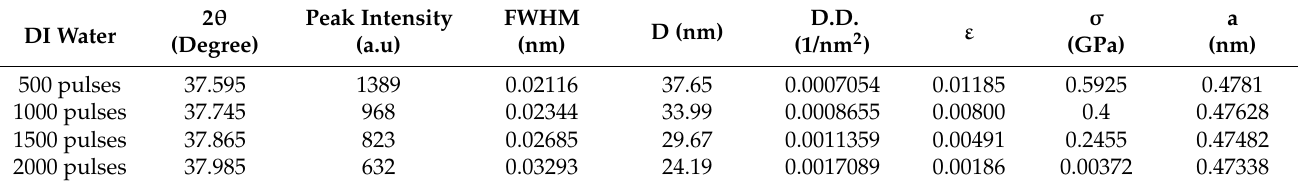
Table 1. The variations in peak intensity, FWHM, C.S, D.D, lattice stain, residual stresses, and lattice parameter of Cd after ablation with KrF excimer laser for 500, 1000, 1500, and 2000 laser pulses at a constant fluence value of 3.6 Jcm − 2 in deionized (DI)